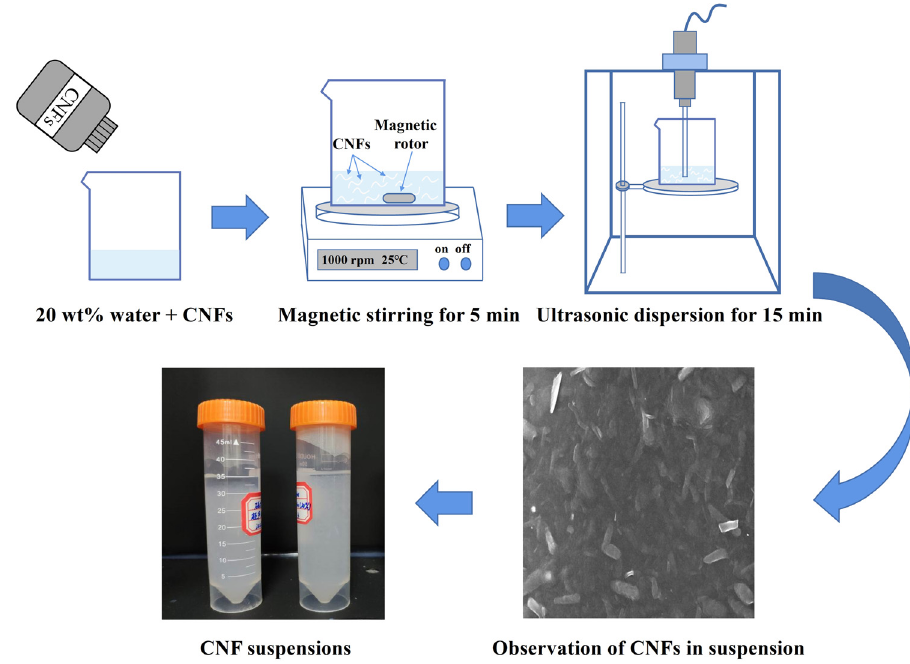
Figure 1: Flow chart of CNF suspension preparation.